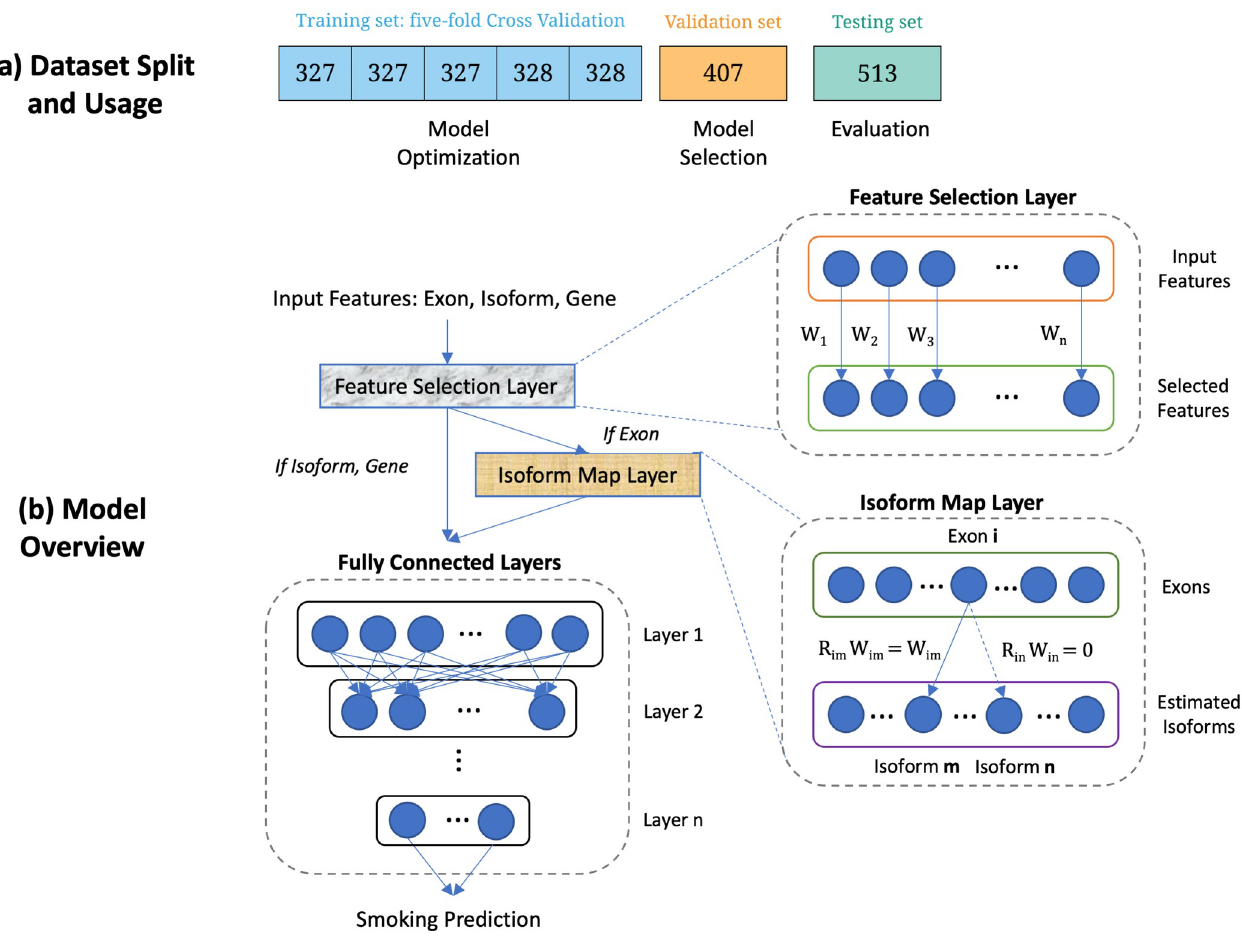
Fig 1. Visual abstract. (a) Dataset split and usage. The number in each cell represents the number of subjects. The training set is equally split into 5 folds for deep learning model optimization (cross-validation for tuning the hyperparameters and architecture search in a deep learning model). The validation set is used to select the optimal model and the testing set is held out for performance evaluation. (b) Model overview. Our model consists of a Feature Selection Layer (FSL), an Isoform Map Layer (IML) (if the input feature is exon) and standard fully connected layers. FSL associates each input feature with a non-negative learnable weight, which represents the importance of features with respect to smoking status. IML encodes exon to isoform relationships via a binary matrix R , such that if exon i is contained within isoform j , we set R ij = 1, otherwise R ij = 0. By (element-wise) multiplying R ij with corresponding learnable weights W , we only consider canonical exon to isoform